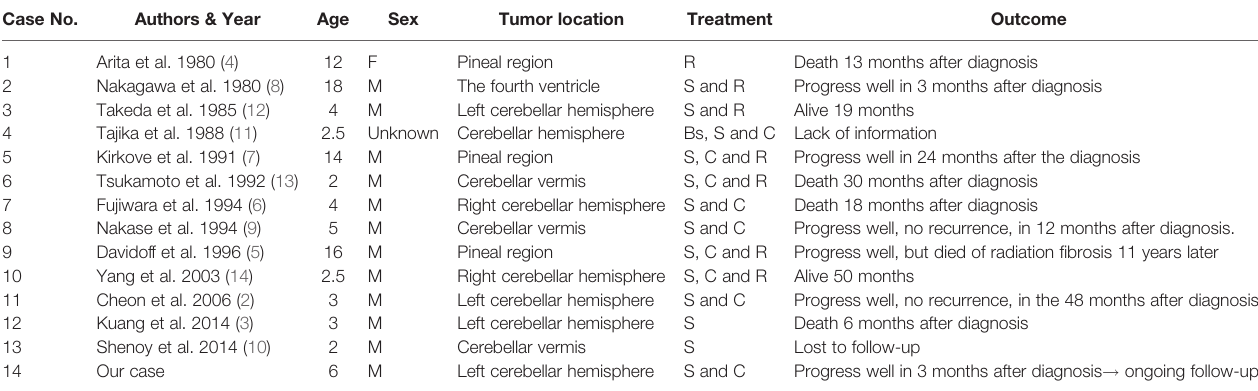
TABLE 1 | Brief review of yolk sac tumor cases of the posterior fossa in the literature. Case No.